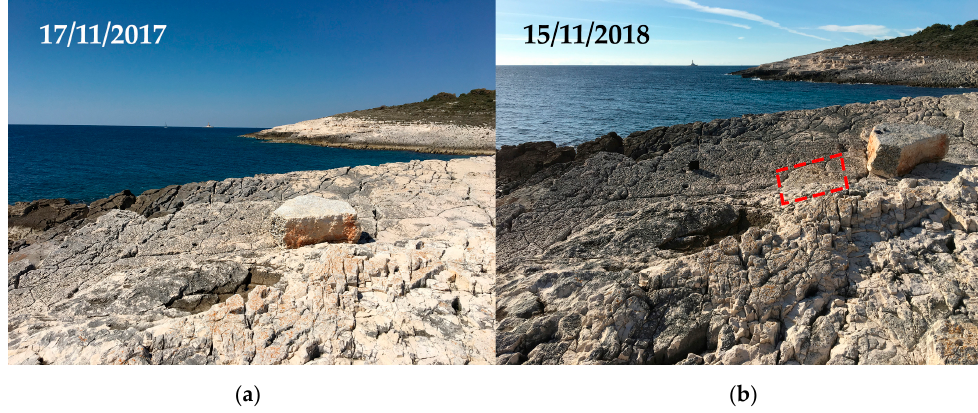
Figure 3. ( a ) Oblique view of boulder #1 and ( b ) the red rectangle indicates its past position on the limestone pavement.